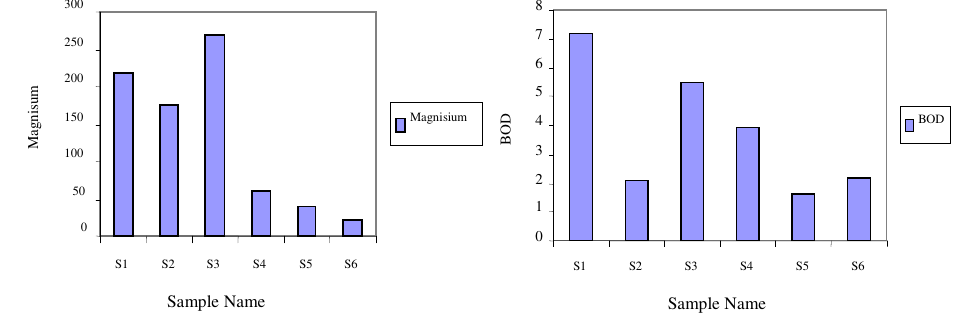
Figure 9. Magnisium Figure 10. BOD in various